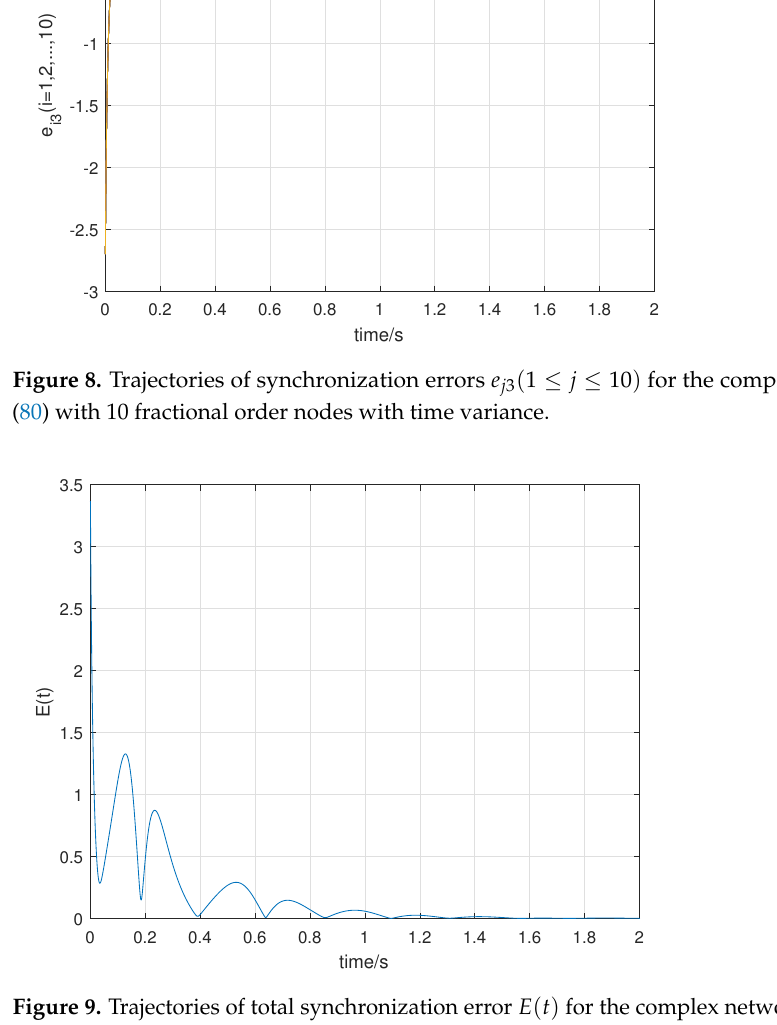
Figure 9. Trajectories of total synchronization error E ( t ) for the complex networks (77) and (80) with 10 fractional order nodes with time